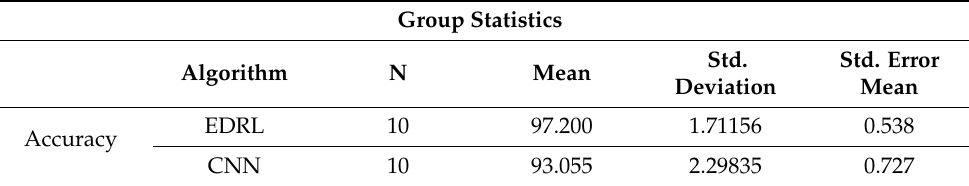
Table 5. Group statistics for accuracy comparison of EDRL vs. CNN algorithms to measure mean, standard deviation, and standard error mean.